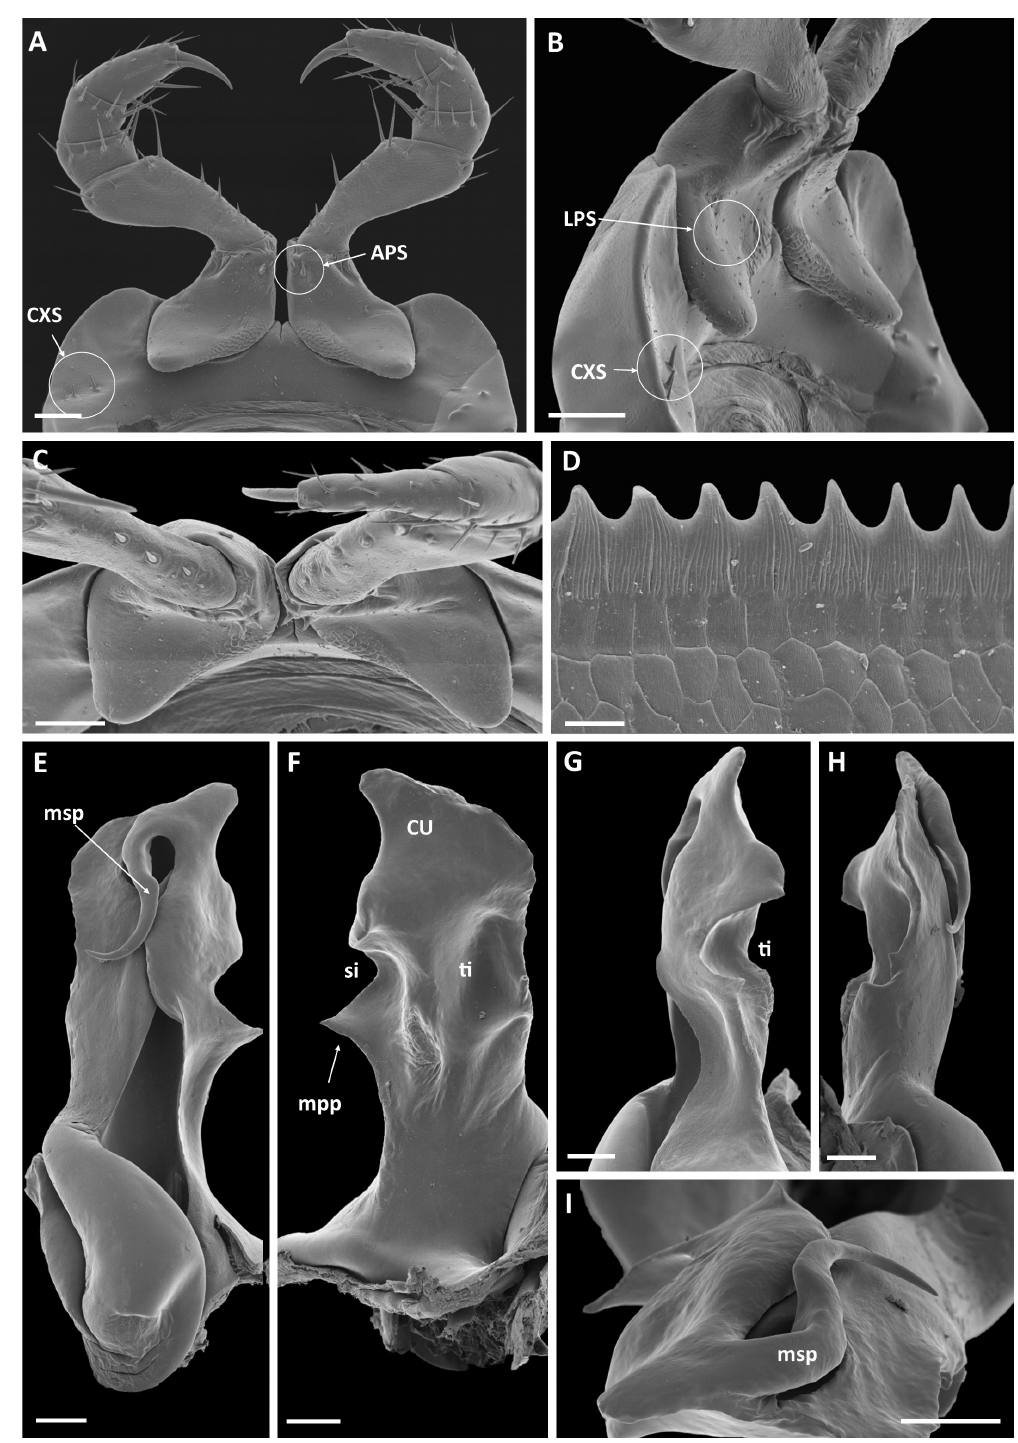
Fig. 21. Calyptomastix zoltani sp. nov., holotype, ♂ (NHMD 621719). A–C . First pair of legs. A. Anterior view. B. Sublateral view. C. Ventral view. D . Midbody dorsal limbus. E–I . Left gonopod coxa. E. Anterior view. F. Posterior view. G. Mesal view. H. Lateral view. I. Subventral view. Abbreviations: APS = mesapical prefemoral setae; CU = cucullus; CXS = coxosternal setae; LPS = lateral prefemoral setae; mpp = mesal proplical process; msp = metaplical spinelike process; si = mesal sinus; ti = transverse impression. Scale bars: A–C, E–I = 0.1 mm; D = 0.01